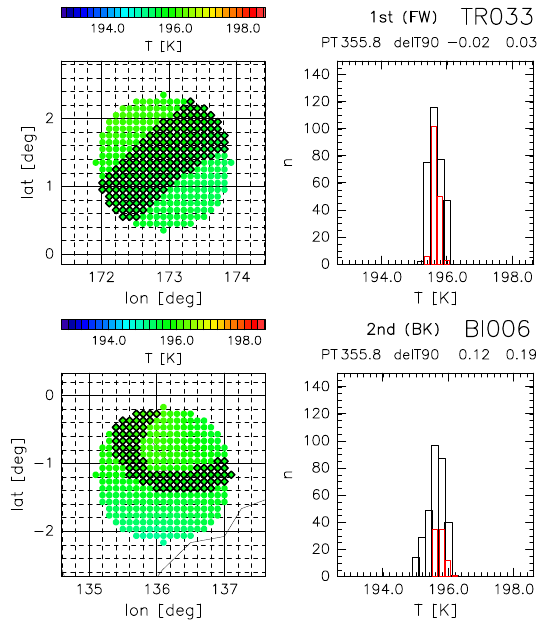
Fig. A1. Representativeness of the match air parcel at Tarawa (top: 05:09UT, 31 December 2005) and Biak (bottom: 01:49UT, 6 Jan- uary 2006). These preliminary matched observations are connected by trajectories at the 355.8K potential temperature surface. Left: Match air segments (diamonds) superposed on color-coded temper- ature of the circular area defined by a match radius. Right: Temper- ature frequency distribution of the whole segments within the cir- cular area defined by a match radius (black bars) and that for match air segments (red bars).